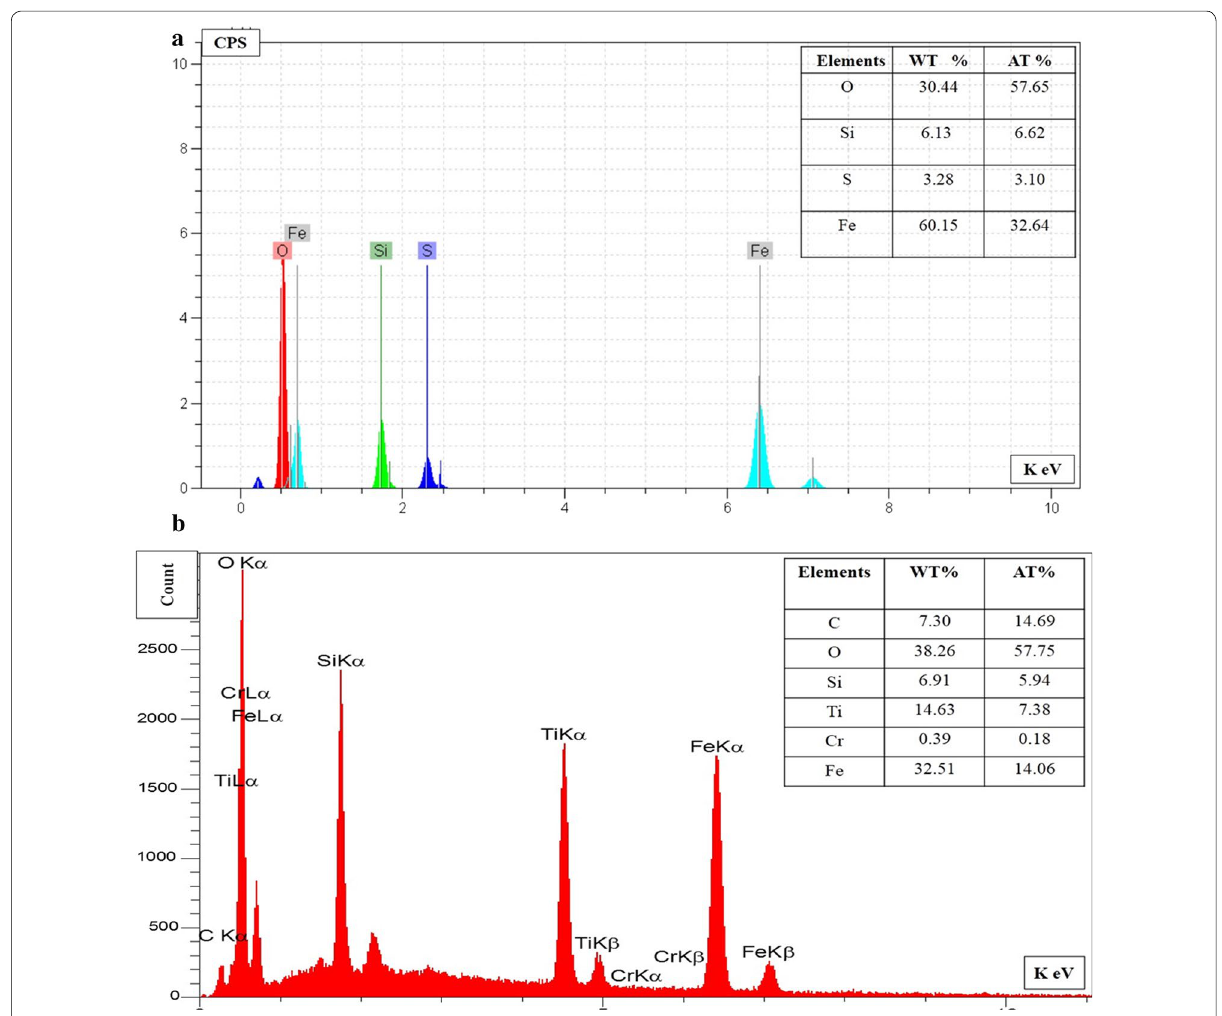
Fig. 2 EDX spectrum of a Fe 3 O 4 /SiO 2 and b Fe 3 O 4 /SiO 2 /TiO 2